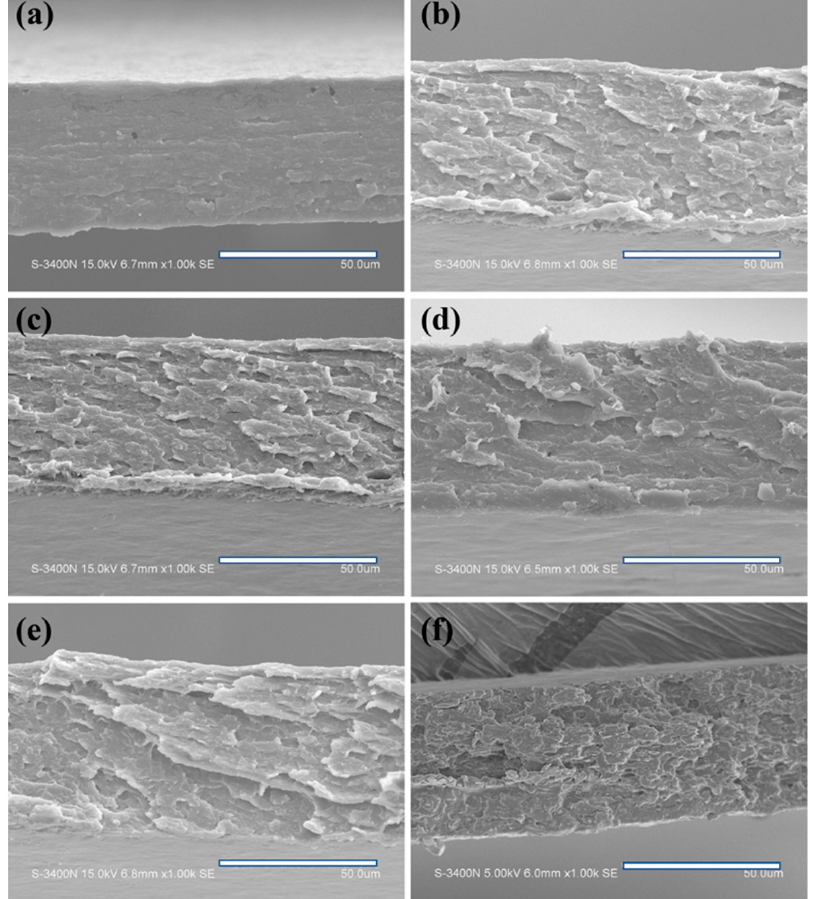
Figure 6. SEM images of stretching section of amylose/PVA blend films (( a ) APF/G0, ( b ) APF/G0.5, ( c ) APF/G1, ( d ) APF/G1.5, ( e ) APF/G2 and ( f ) APF/G5), at 1000 × magnification. ( c ) APF/G1, ( d ) APF/G1.5, ( e ) APF/G2 and ( f ) APF/G5), at 1000 ×